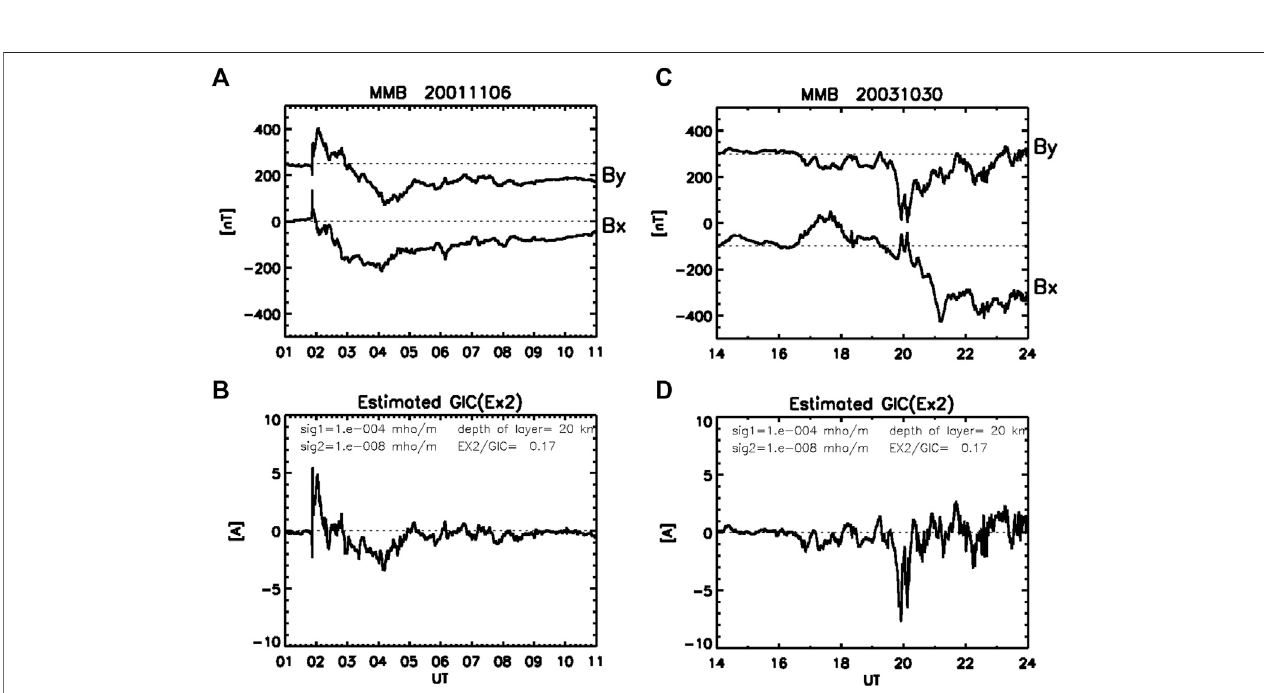
FIGURE10|(A) GeomagneticstormsrecordedatMMBinthedaytime(01-09UT,10-18MLT)onNovember06,2001and (B) inthemidnight-morning(16-24UT, 01-09 MLT) on October 30, 2003. (C) (D) GICs estimated from E x2 with the scale factor same as in Figures 8 , 9 .